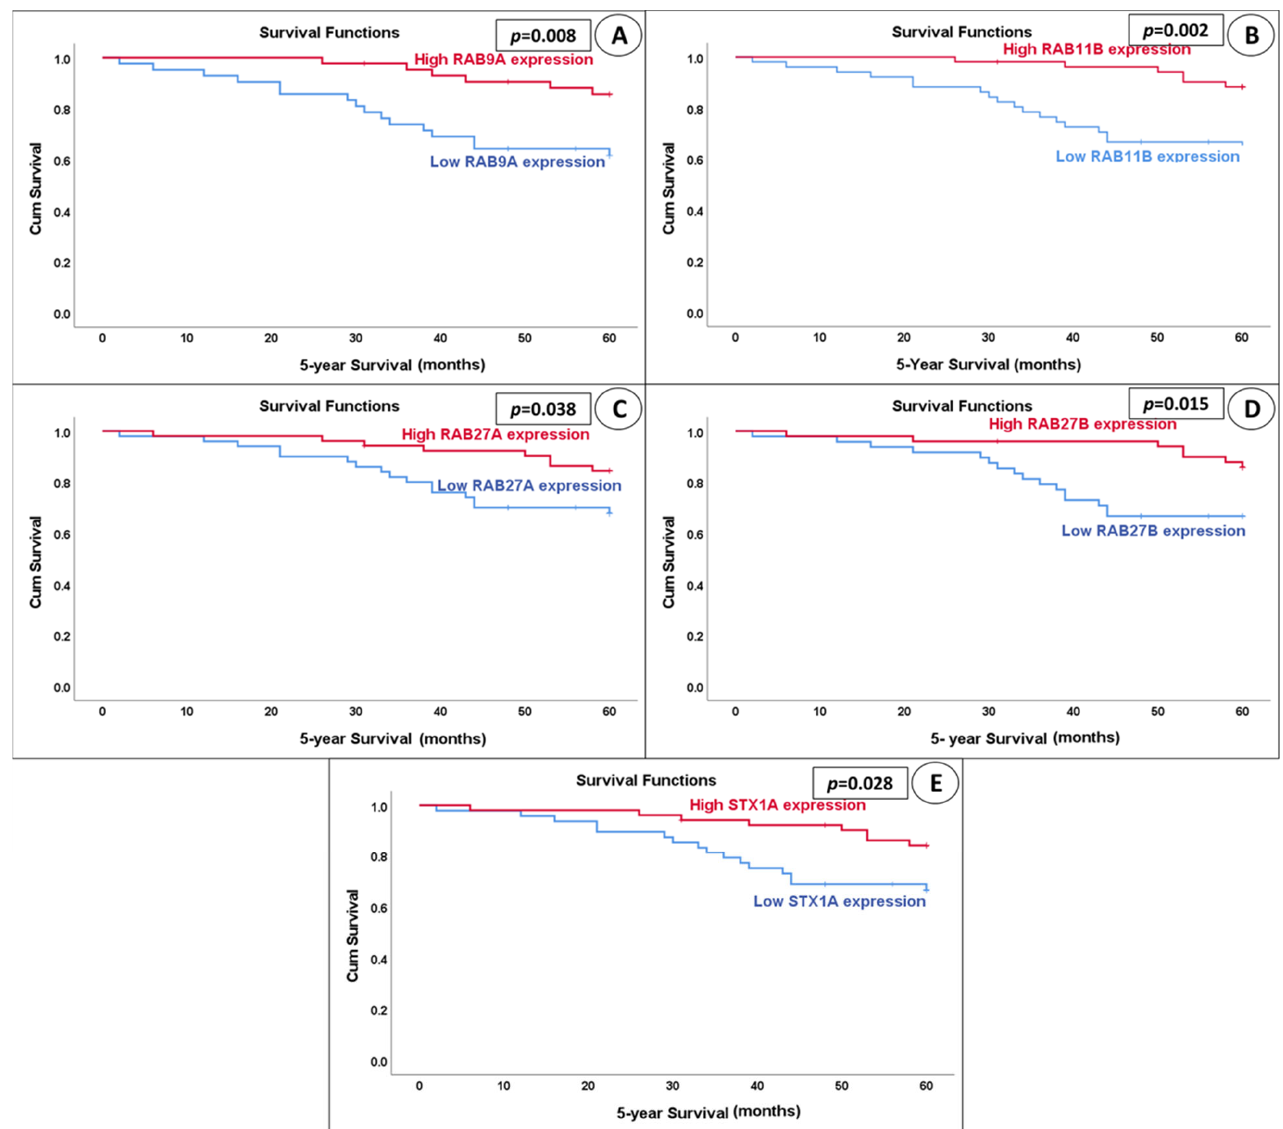
Figure 5. Kaplan Meier curves for 5 ‐ year overall survival of RAB27A ( A ), RAB27B ( B ), RAB9A ( C ), RAB11B ( D ), and STX1A ( E ) (n = 109). Patients with higher expression of those genes have longer 5 ‐ year survival.